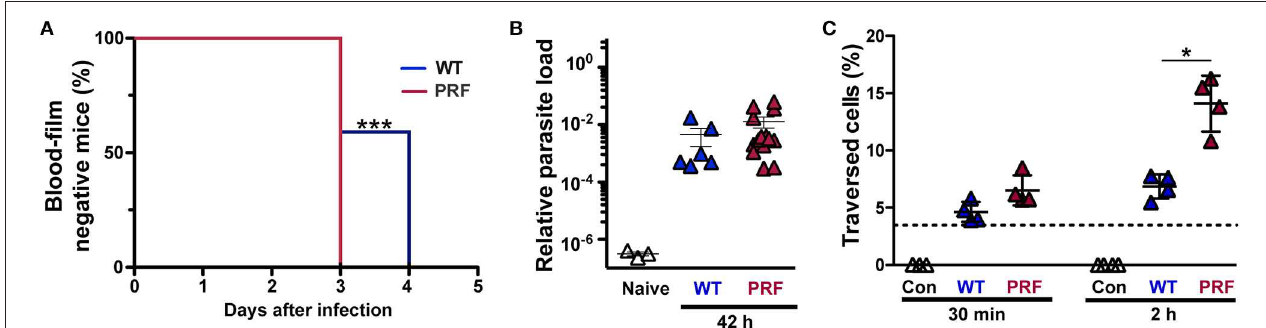
FIGURE 1 | Improved pre-erythrocytic development of PRF parasites. (A) Prepatent period of sporozoite-induced infections. Appearance of blood-stage parasites was monitored by daily microscopic examination of Giemsa-stained blood films. C57BL/6 mice were infected by intravenous injection of 5,000 WT or PRF hemocoel sporozoites ( n = 22 each). Shown is a Kaplan-Maier analysis of time to first detection of blood infection, *** P < 0.001 (Mantel-Cox test). (B) In vivo quantification of parasite loads in the liver of infected mice. Livers were harvested 42h after infection of C57BL/6 mice by intravenous injection of 5,000 WT or PRF hemocoel sporozoites. Expression levels of P. berghei 18S rRNA were quantified by real-time RT-PCR and normalized to mouse GAPDH . Results represent mean values ( ± SEM) ( n = 8 each for infected mice; n = 3 for naïve mice). Differences between WT- and PRF-infected livers were non-significant (Mann-Whitney test). (C) Sporozoite cell traversal. Hepatoma cells were incubated for 30min or 2h with medium (white; Con), FITC-dextran only (dotted line), and FITC-dextran together with either WT (blue; WT), or PRF (red; PRF) hemocoel sporozoites. Cells were analyzed by flow cytometry to enumerate the percentage of dextran-positive cells indicative of sporozoite traversal. Results represent mean values ( ± SD) of at least three independent experiments with duplicates each. * P < 0.05 (Mann-Whitney